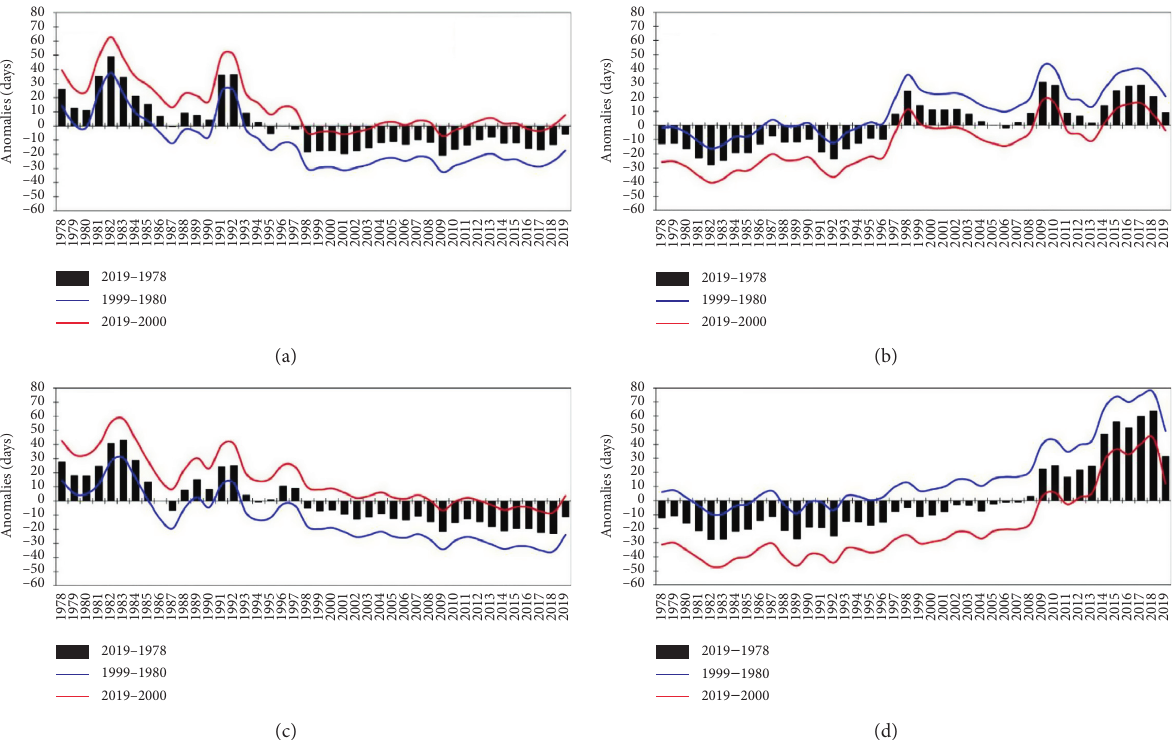
Figure 12: Country-averaged anomaly relative to entire period (1978–2019) mean values of four percentile-based indices: (a) TX10p; (b) TX90p; (c) TN10p; (d) TN90p. Solid red and blue lines represent the anomaly relative to 2000–2019 (warmer) and 1980–1999 (colder) period,